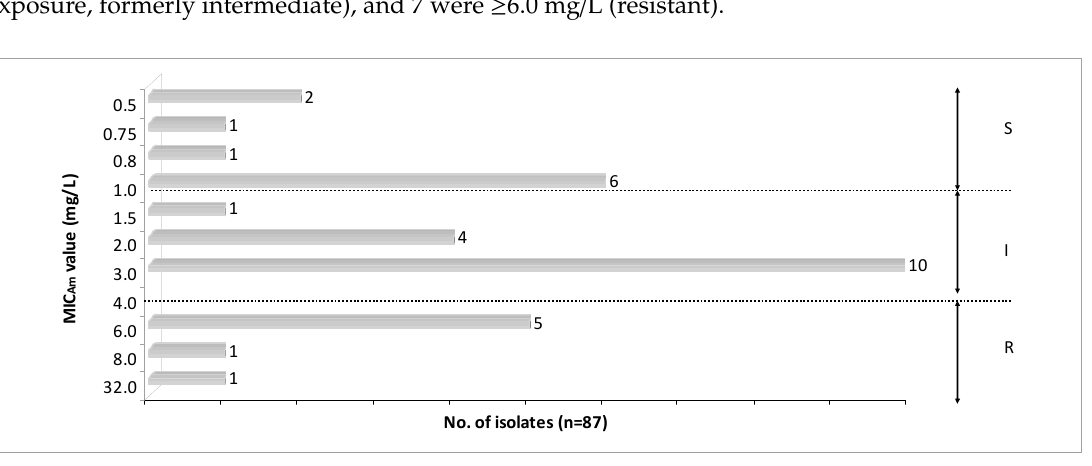
Figure 1 . Distribution of resistance to beta-lactam antibiotics among Haemophilus parainfluenzae isolates ( n = 87) . Am—ampicillin, Cxm—cefuroxime (oral), Ctx—cefotaxime, Ipm—imipenem,